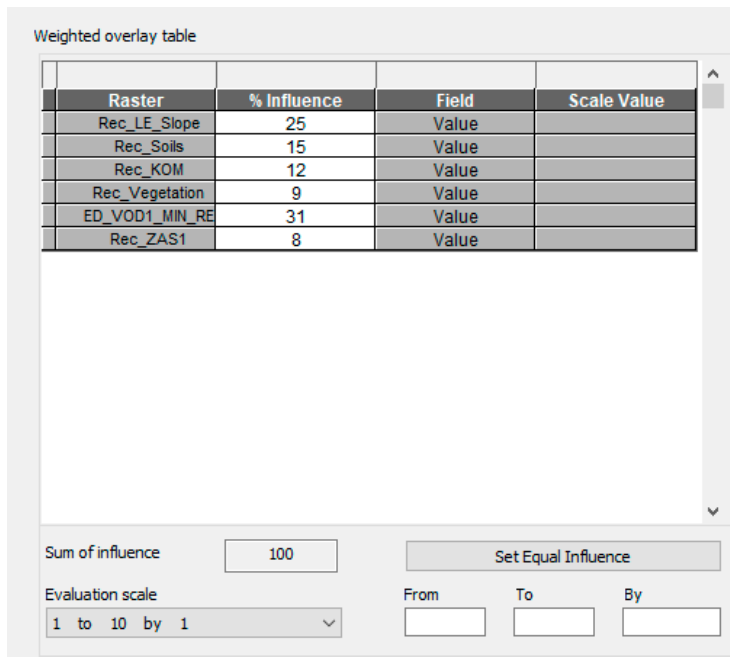
Figure 7. Example of setting weights of entry layers with weighted overlay.